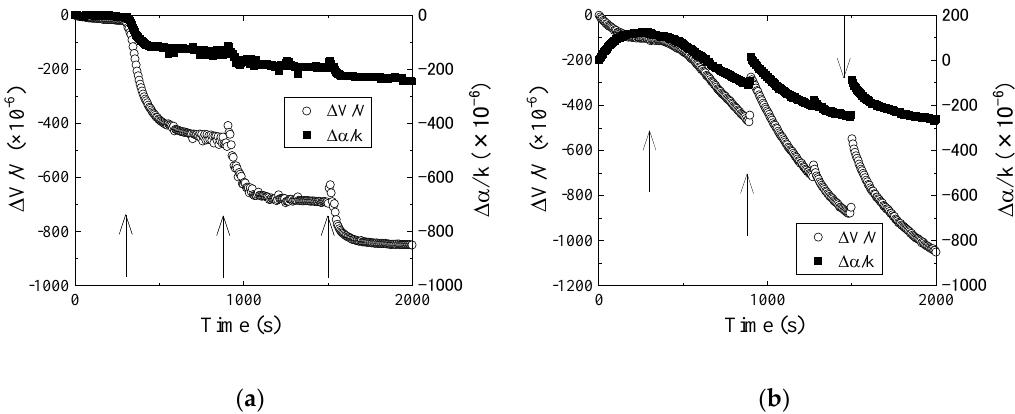
Figure 6. Measured results of ( a ) iron and ( b ) carbon powders in new engine oil obtained from the differential signal between Ch. 1 and Ch. 2. The arrow indicates the addition time of the particles of 0.5 mg.